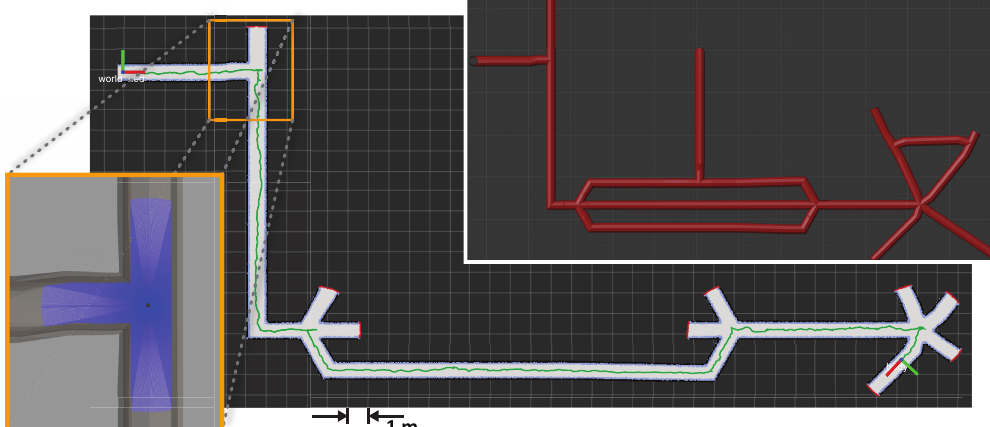
Figure 14. Autonomous horizontal exploration result. Main image: traveled path as green line; detected frontiers as red lines and appearing on the edges of the unexplored tunnels. Overlaid top-right image: model of the mine used for